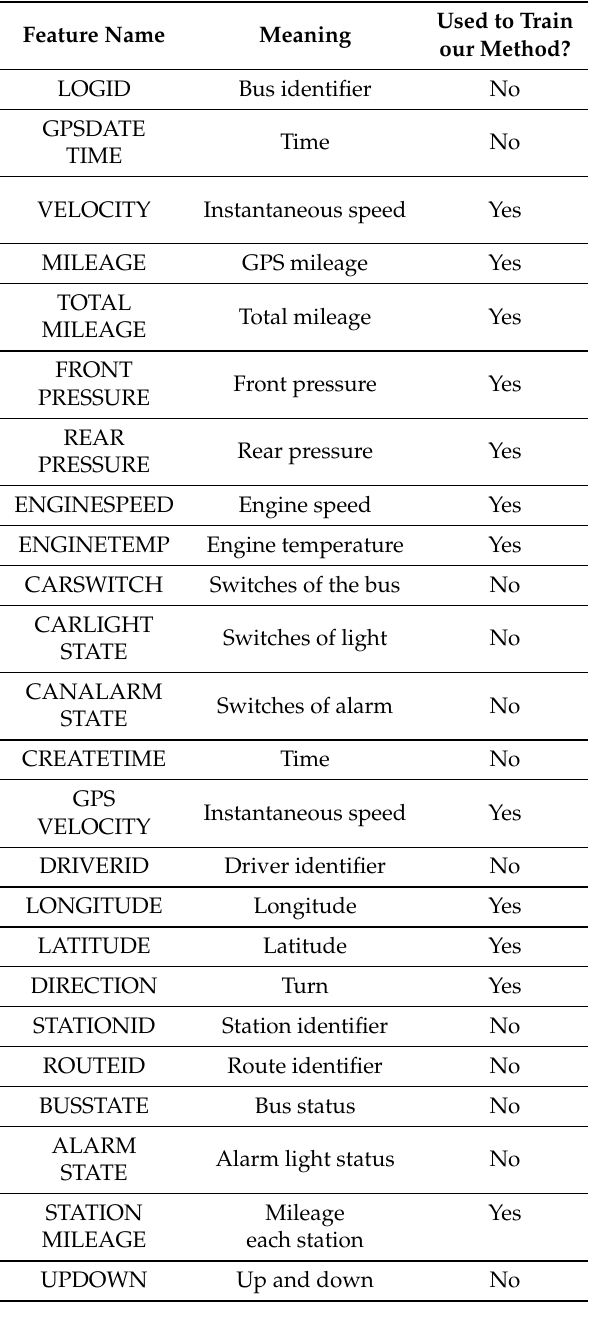
Table 1. Features in our dataset to evaluate road safety.